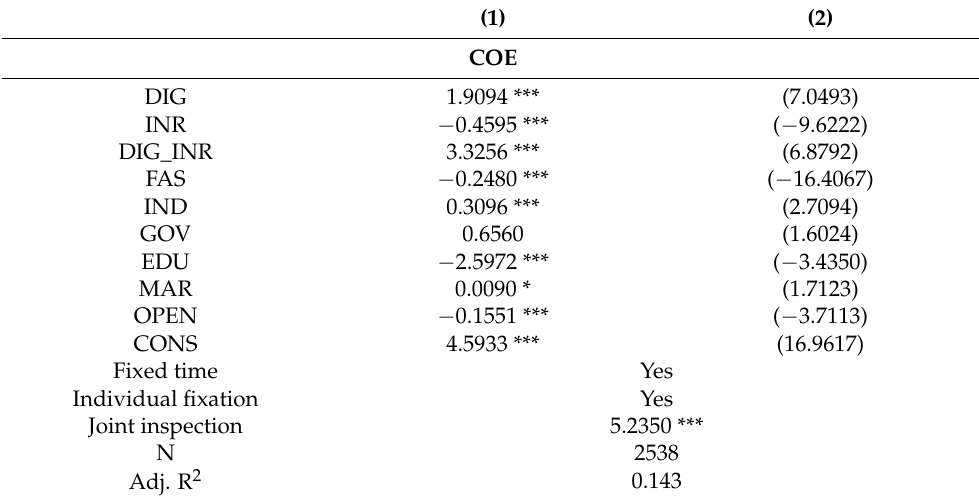
Table 8. Inspection of the regulating effect of rationalization of industrial